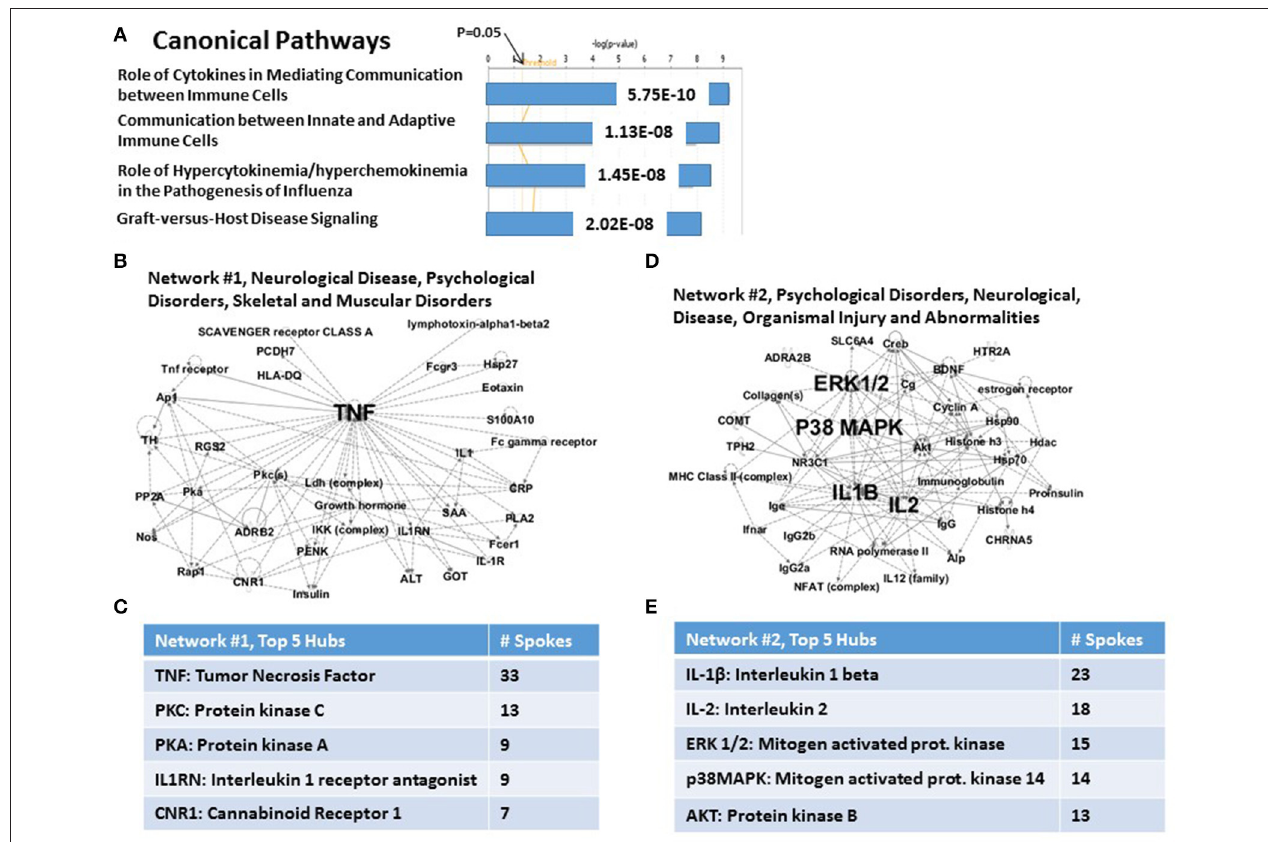
FIGURE 3 | Functional relationship among 36 candidate PTSD genes, which share an independent risk factor status with cardiovascular disease. (A) Top canonical pathways. The top signaling pathway is Role of Cytokines in Mediating Communication between Immune Cells. (B) Associated Network Function #1. The top hub is TNFalpha, (C) Inset : Network #1, top 5 hubs. (D) Associated Network Function #2. The top hubs are IL-1 β , IL-2, p38MAPK, and ERK1/2. (E) Inset : Network #2, top 5